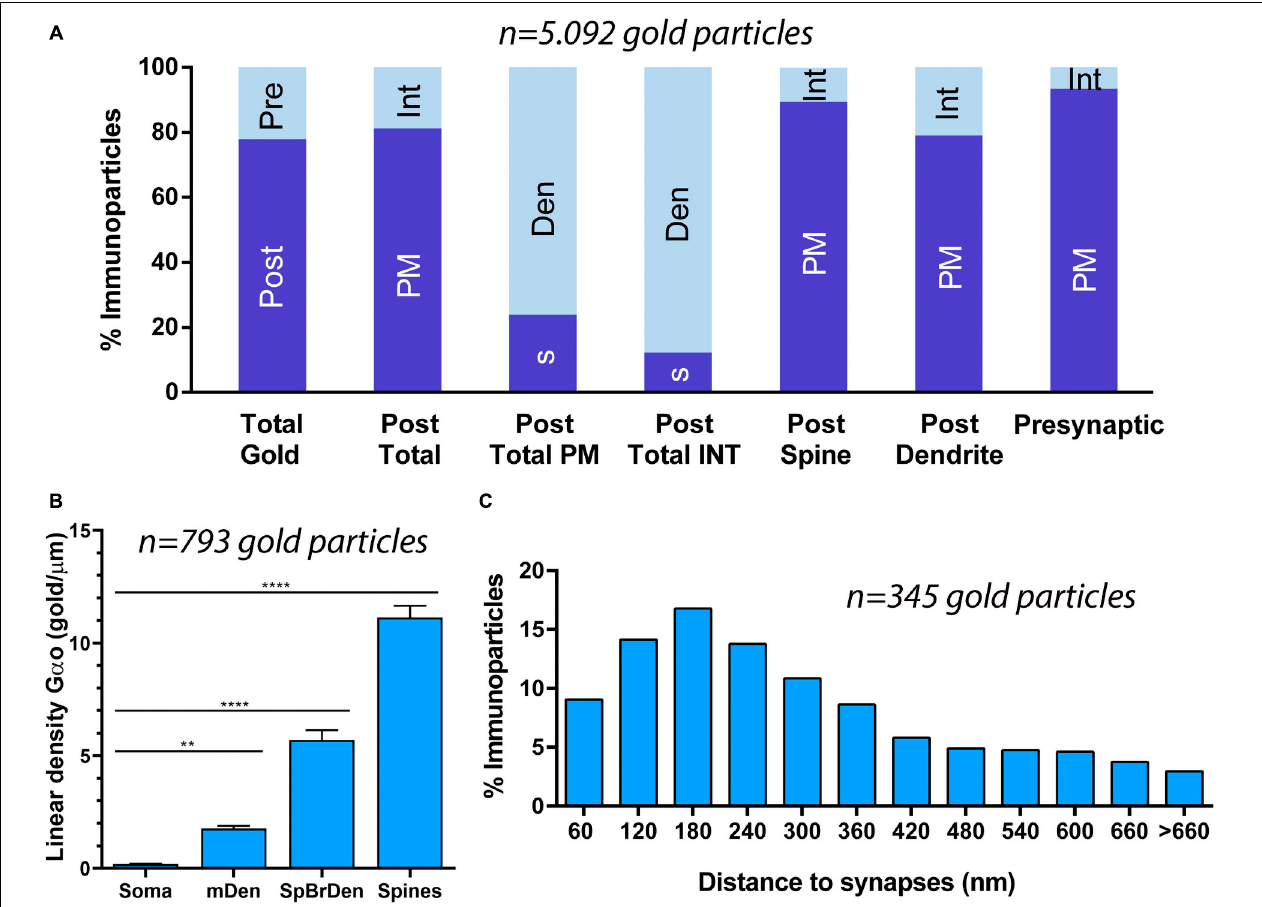
FIGURE 4 | Compartmentalization of G α o in PCs. (A) Histogram showing the percentage of immunoparticles for G α o in neuronal compartments in the molecular layer. A total of 5,092 immunoparticles in the molecular layer were analyzed, of which 78% were postsynaptic and 22% were presynaptic. Immunoparticles for G α o at postsynaptic sites were found in PC dendrites (76.08%) and in PC spines (23.92%), being mainly distributed along the plasma membrane (79.02% in dendrites and 89.44% in spines) and intracellularly (20.98% in dendrites and 10.56% in spines). Immunoparticles for G α o at presynaptic sites were detected in parallel fiber terminals mostly distributed along the plasma membrane (93.43%) and to a lesser extent at cytoplasmatic sites (6.57%). (B) Somato-dendritic gradient of G α o along the surface of PCs showing that density of immunoparticles increased significantly from soma to dendritic spines. Error bars indicate SEM; ** P < 0.002; **** P < 0.0001. mDen, main dendrites; SpBrDen, spiny branchlet dendrites. (C) Histogram showing the proportion of immunoparticles for G α o at a given distance from the edge of PSDs in PC spines-parallel fiber synapses. The data shows that 65% of G α o were distributed in a 60–300 nm wide band, indicating its proximity to excitatory